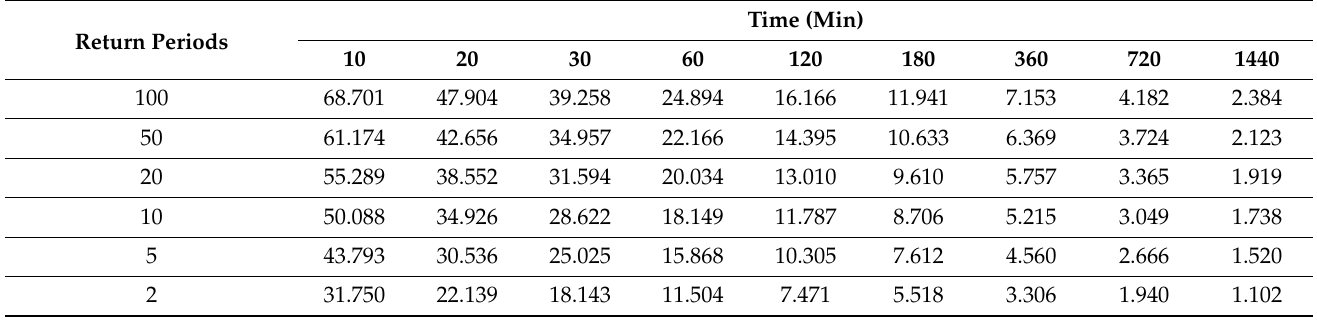
Table 6. Curve values (intensity, duration, frequency) for different return periods to the study station.